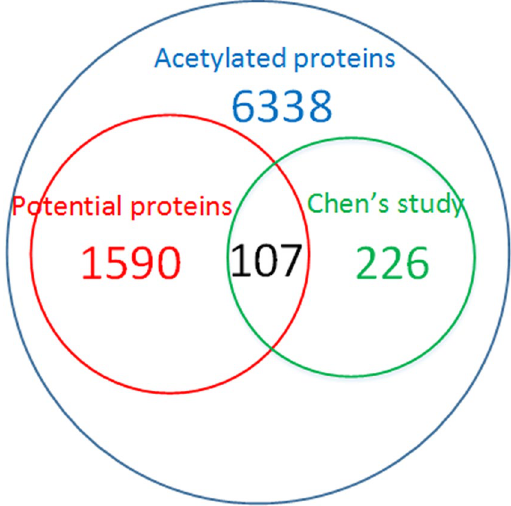
Figure 5. Overlap between our prediction results and Chen’s